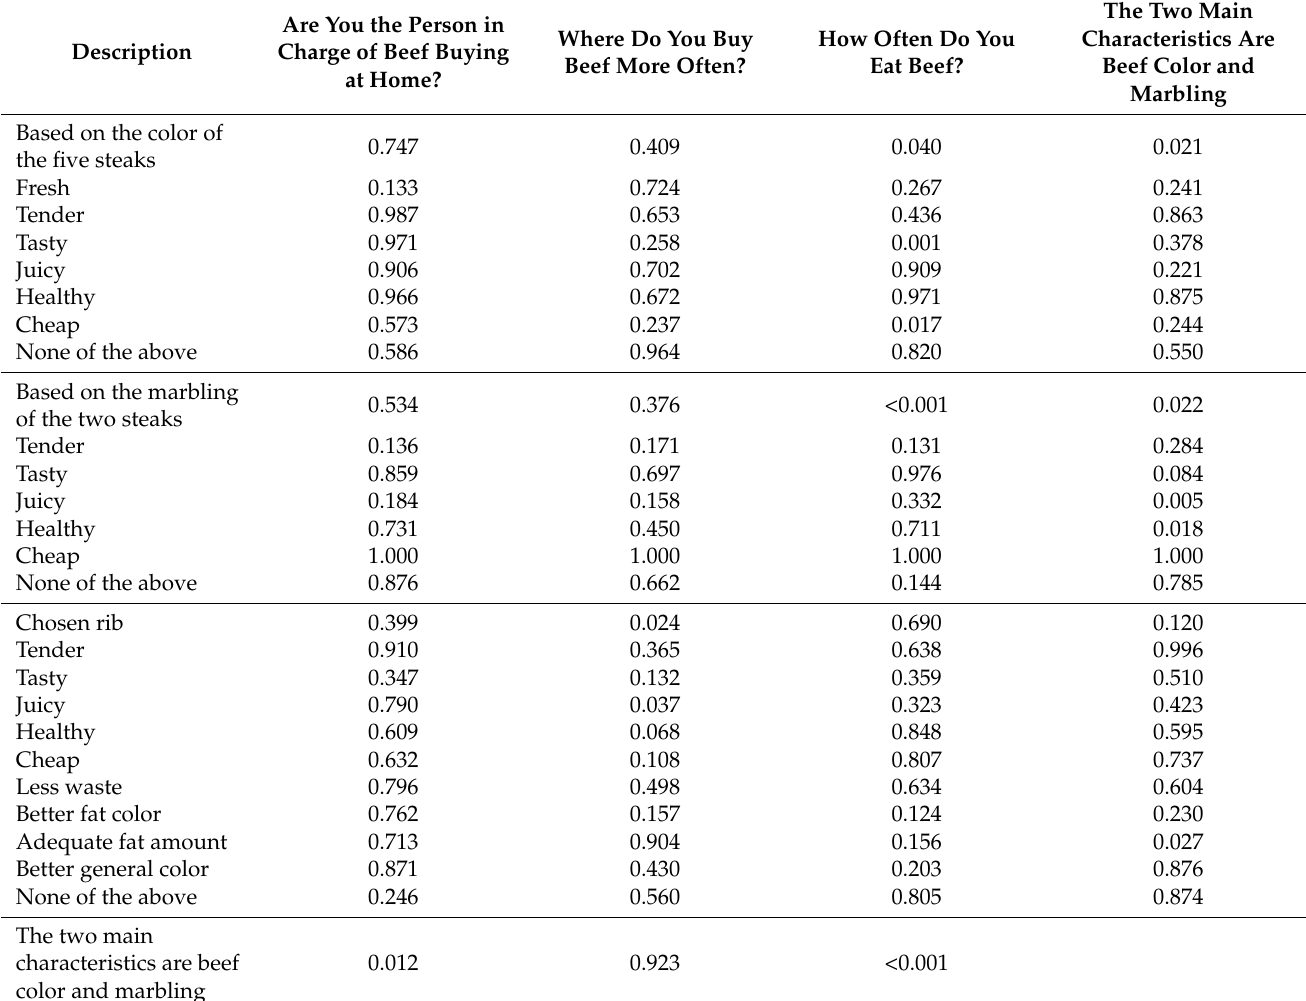
Table 5. Chi-square p -values for the Kruskal–Wallis test with purchase habits and beliefs as main